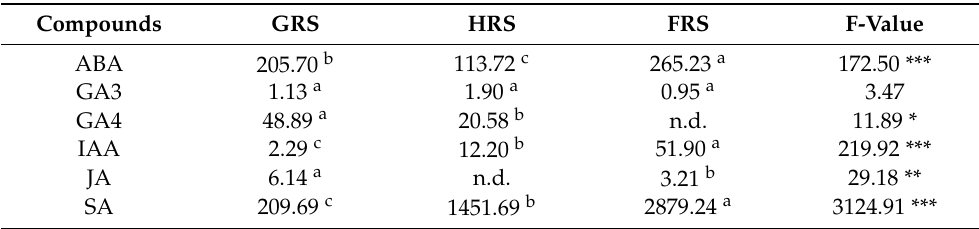
Table 3. Changes in the phytohormone compositions (ng/g) in Coccinia Grandis fruits to the dry matter at different stages of